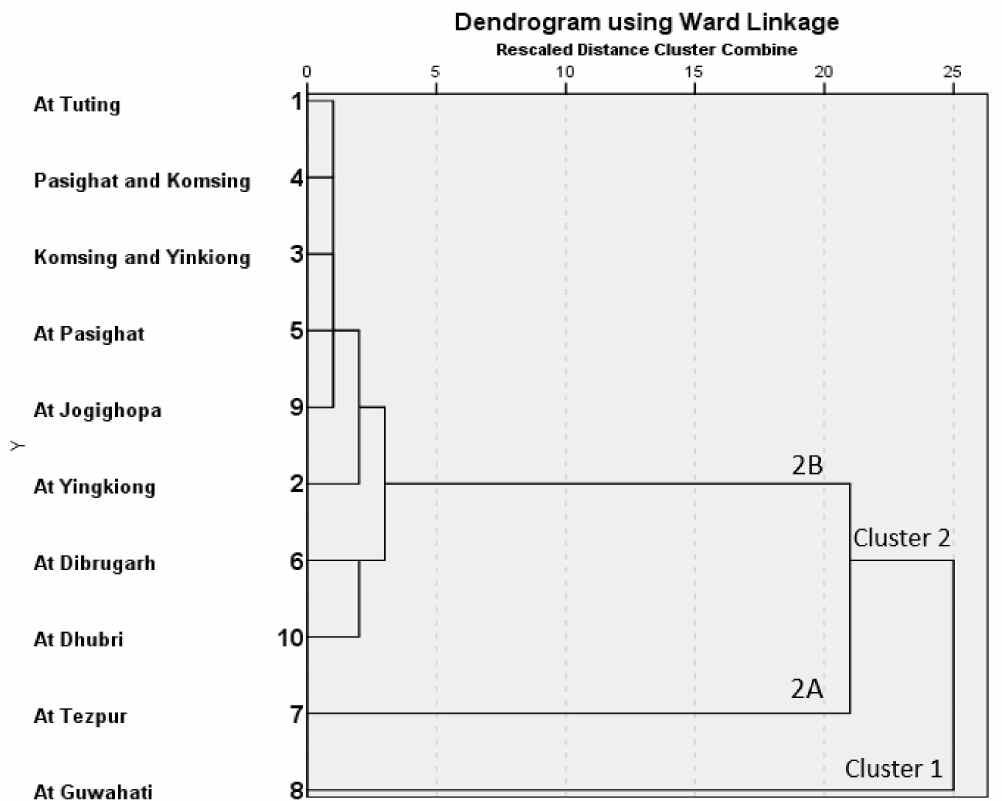
Figure 4. Cluster analysis dendrogram of the sampling